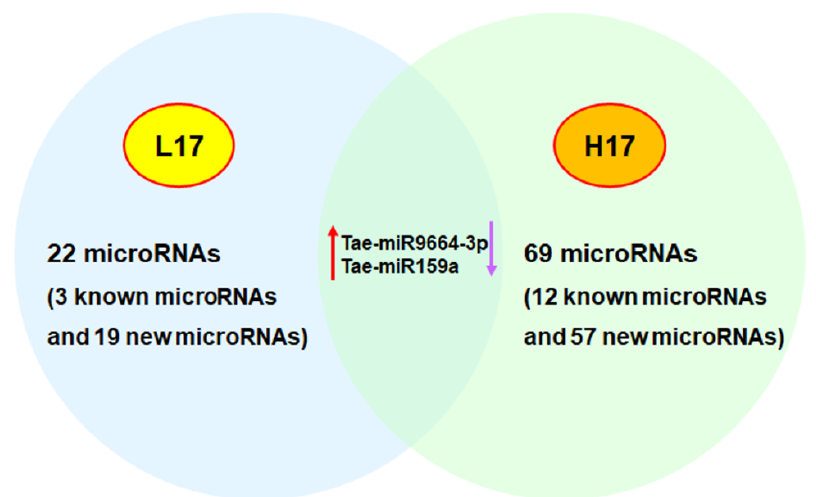
Figure 4. Differentially expressed microRNAs in the roots of two wheat cultivars (L17 and H17) under Cd stress. Tae-miR9664-3p and Tae-miR159a were upregulated in L17Cd (Cd treated) compared to L17CK but downregulated in H17Cd. Up red arrow represents upregulated (Tae-miR9964-3p and Tae-miR159a) in L17Cd compared to L17CK. Down purple arrow represents downregulated in H17Cd compared to H17CK.